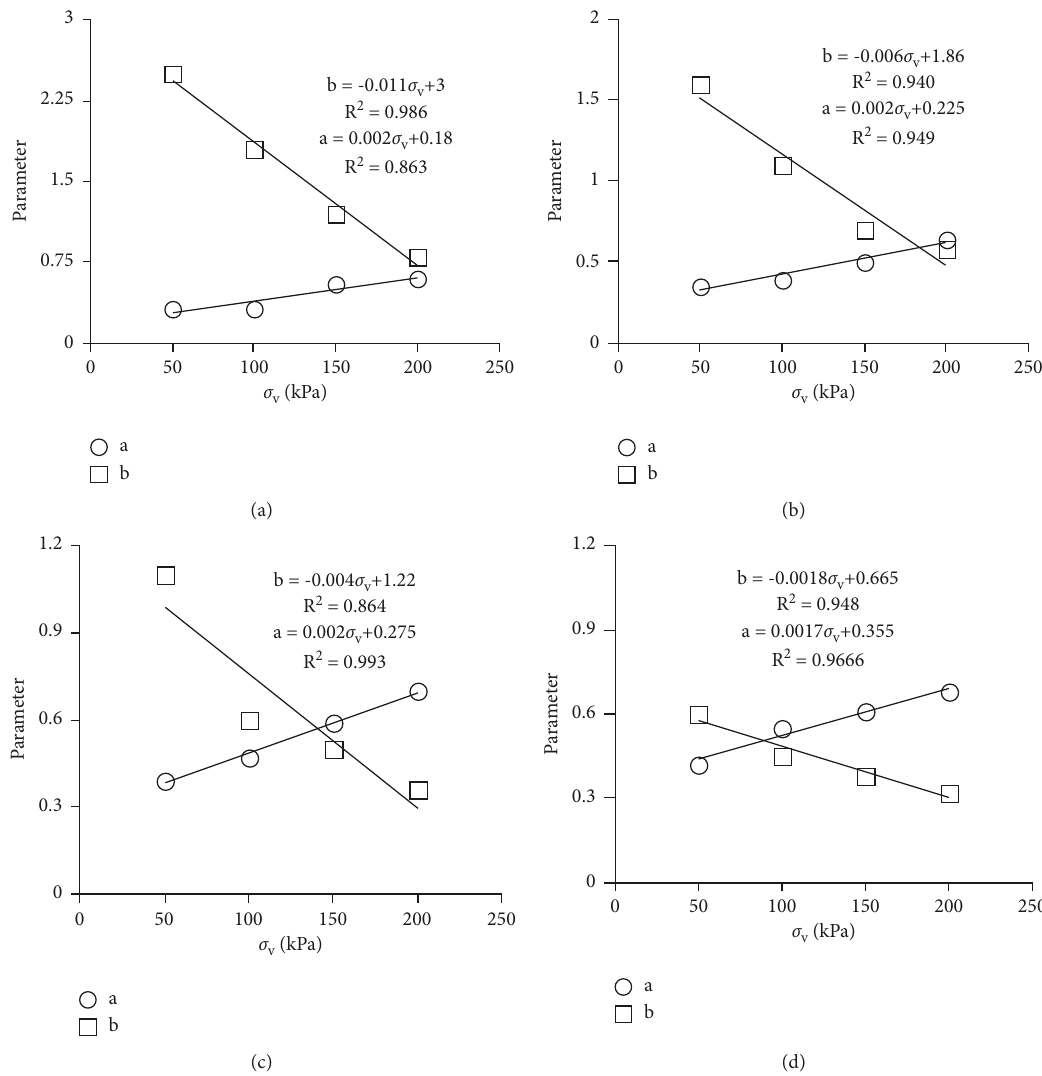
Figure 10: Parameters a and b versus vertical stress under different water contents (a) � 5%, (b) � 10%, (c) � 15%, and (d) �